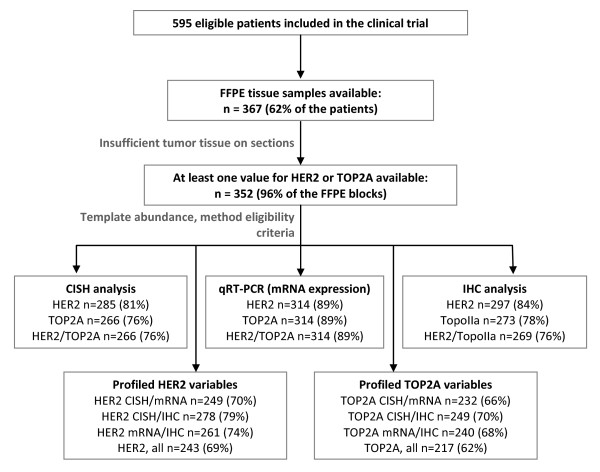
REMARK diagram detailing FFPE tissue and sample availability in the present study for the application of different analytical techniques for the determination of HER2 and TOP2A gene status, mRNA and protein expression. The rates in parentheses for CISH, qRT-PCR and IHC were calculated against the number of tissue samples with at least one HER2 or TOP2A value available (n = 352).